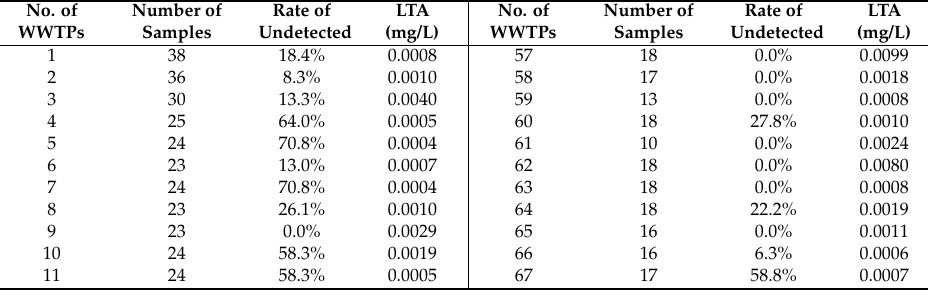
Table 8. LTAs of As for 112